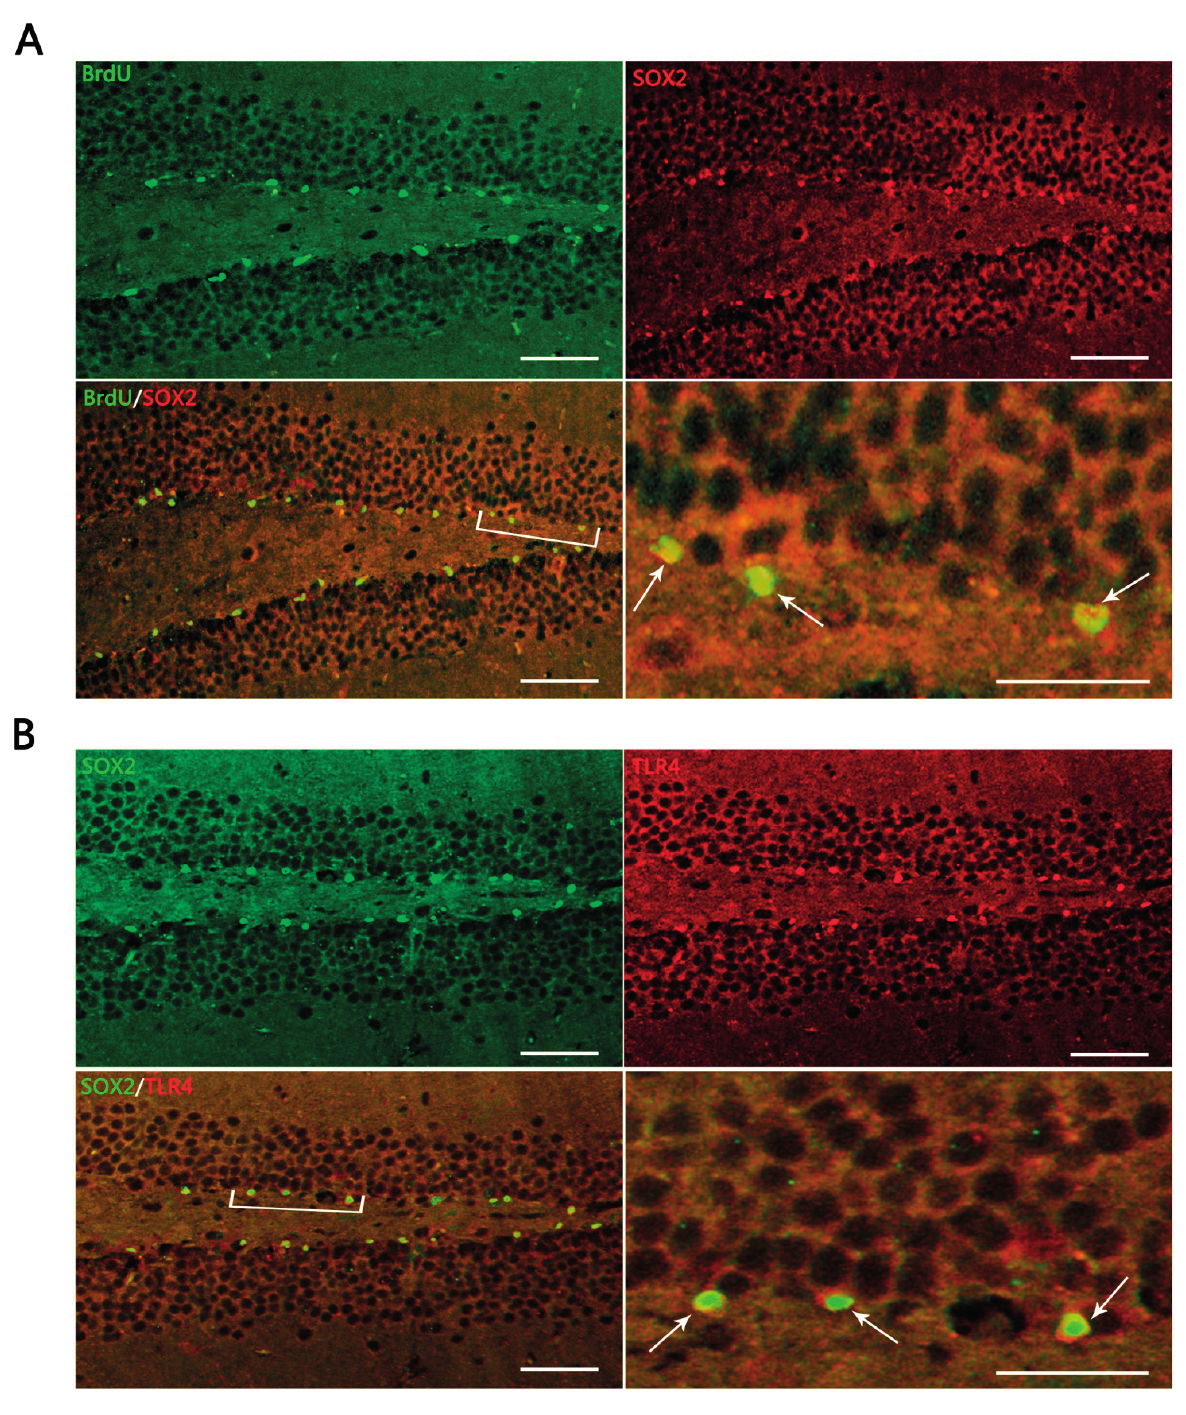
Figure 3. Representative IF microphotographs in the DG of hippocampus in sham- and TBI-mice with various post-injury survival periods. ( A ) BrdU (green), indicating proliferating cells in DG, SOX2 (red), indicating NSCs in DG; merged IF of BrdU/SOX2 indicates that the proliferating cells are presumed, morphologically, to be NSCs (the percentage of putative NSCs in proliferating cells was 95.80% ± 7.91%); the arrows indicate BrdU + /SOX2 + cells in DG; ( B ) SOX2 (green) indicating NSCs in DG; TRL4 (red), indicating TLR4 expression in DG; merged IF of SOX2/TLR4, indicates TLR4 expression on NSCs, the arrows indicating SOX2 + /TLR4 + cells in DG. The bracketed area is magnified respectively as the right lower part in ( A ) and ( B ). Scale bar: 50 μ m; Data are presented as Mean ± SD, n =